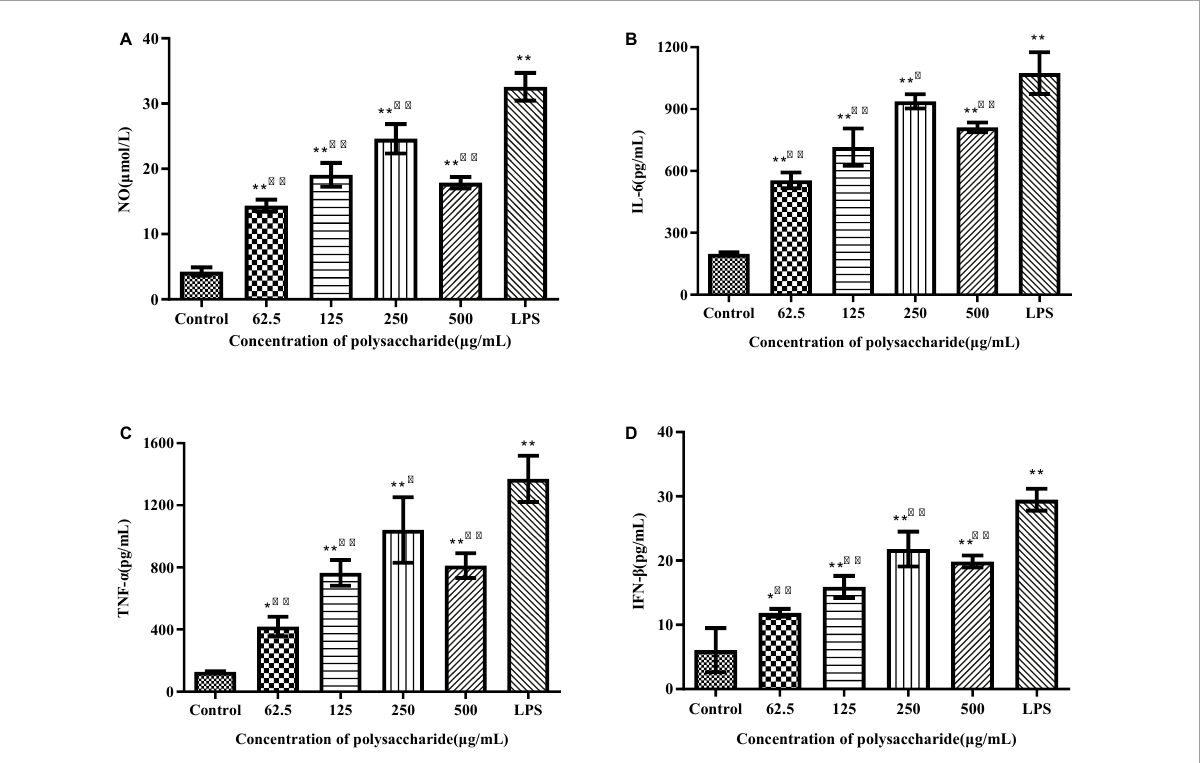
FIGURE7 Effects of SLNP on NO (A) , IL-6 (B) , TNF- α (C) , IFN- β (D) production in RAW264.7 macrophage. Compared with blank control group, * p < 0.05, ** p < 0.01; Compared with LPS control group, (cid:49) p < 0.05 , (cid:49)(cid:49) p <